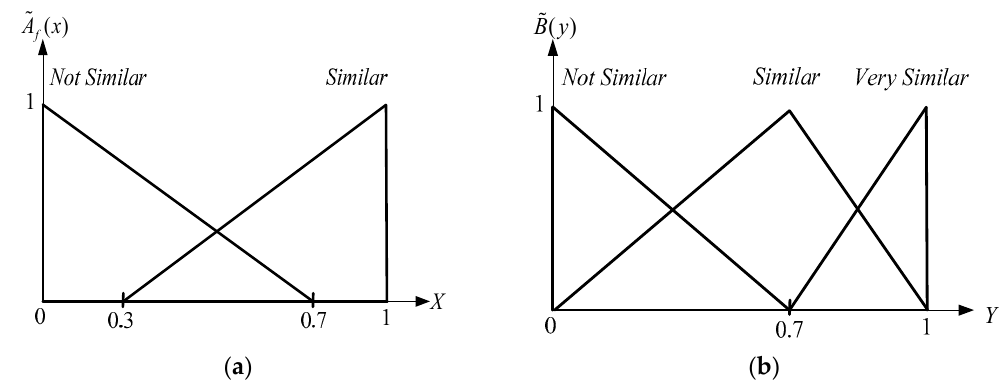
Figure 5. The input and output membership functions. ( a ) Input: x